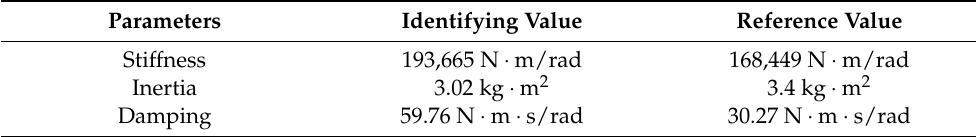
Table 2. Identification